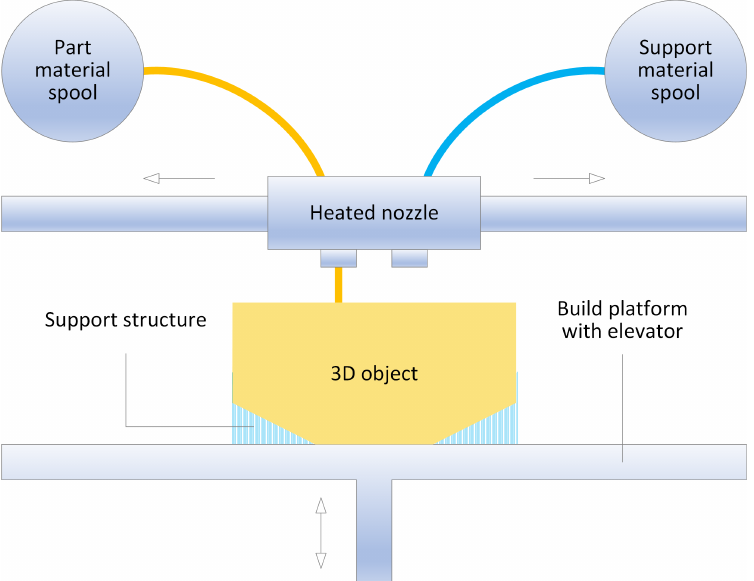
Figure 1. Schematic diagram of the FDM